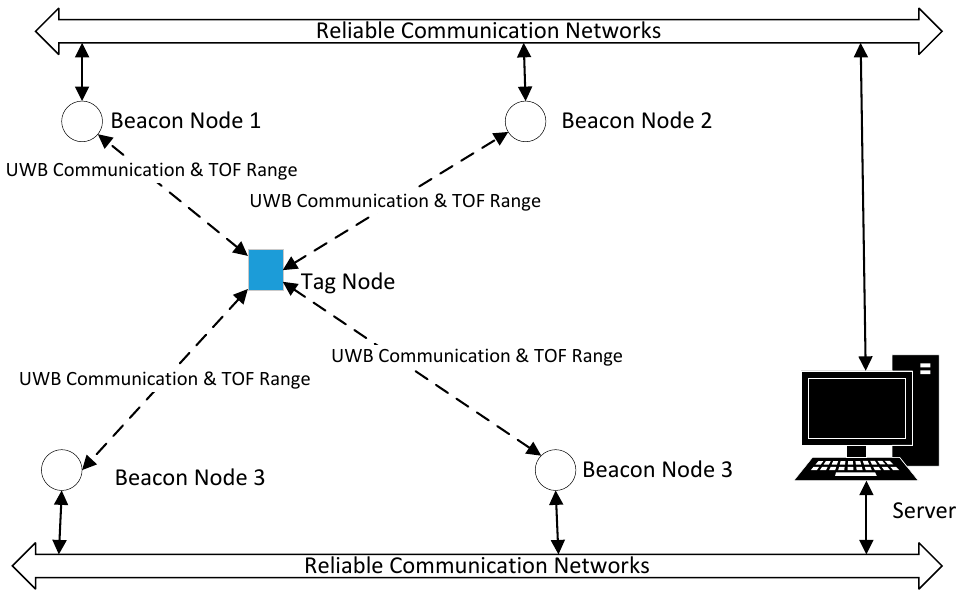
Figure 1. Communication structure of the radio frequency (RF)-based positioning system.